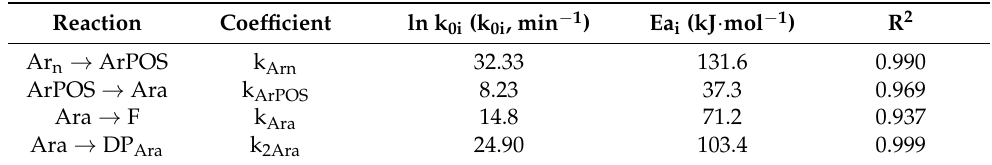
Table 6. Results calculated for the parameters governing the reactions of arabinosyl groups and the derived